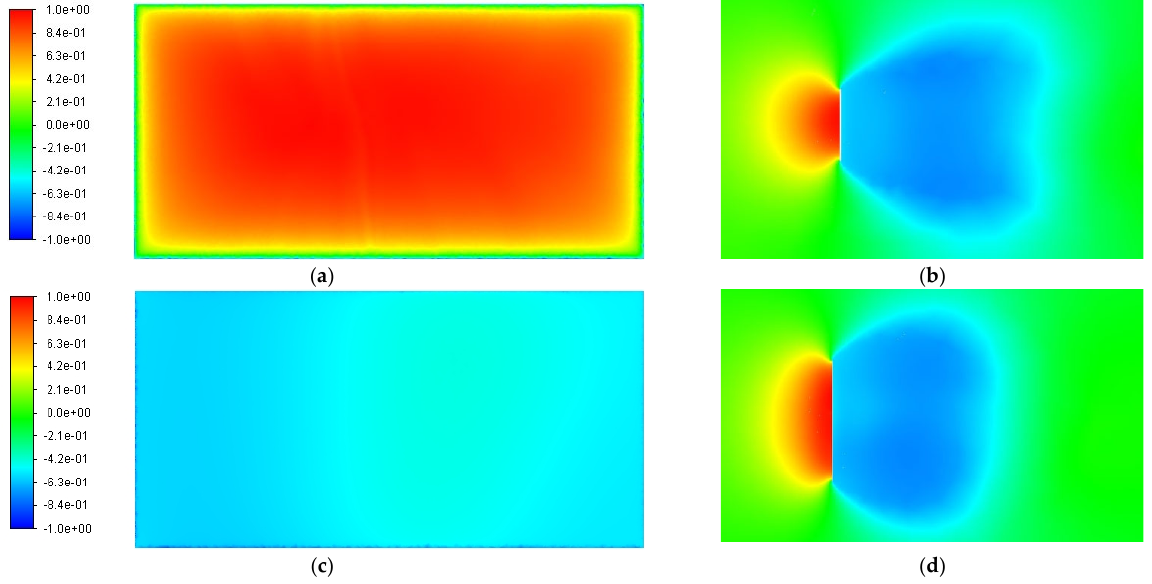
Figure 5. Pressure coefficients contour on the standard panel: ( a ) windward face, ( b ) side view, ( c ) leeward face, and ( d ) top view.